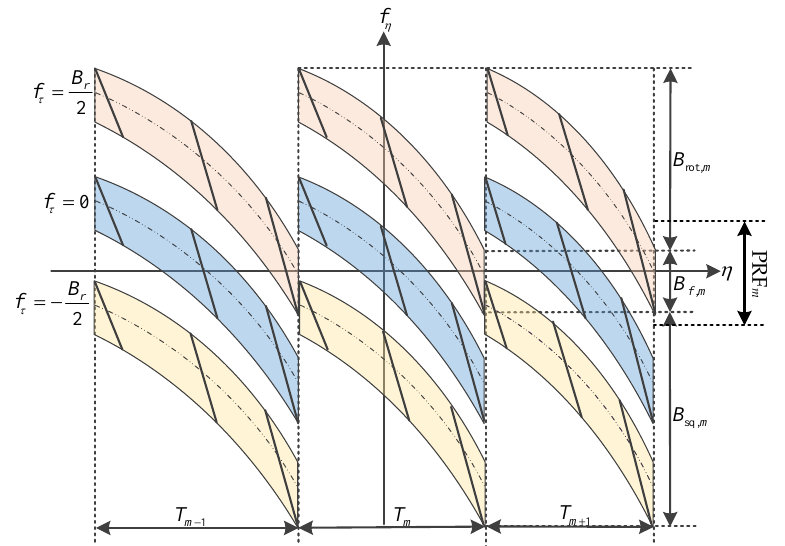
Figure 9. Azimuth time – frequency diagram of squint sliding-spotlight SAR data with BV-PRF.